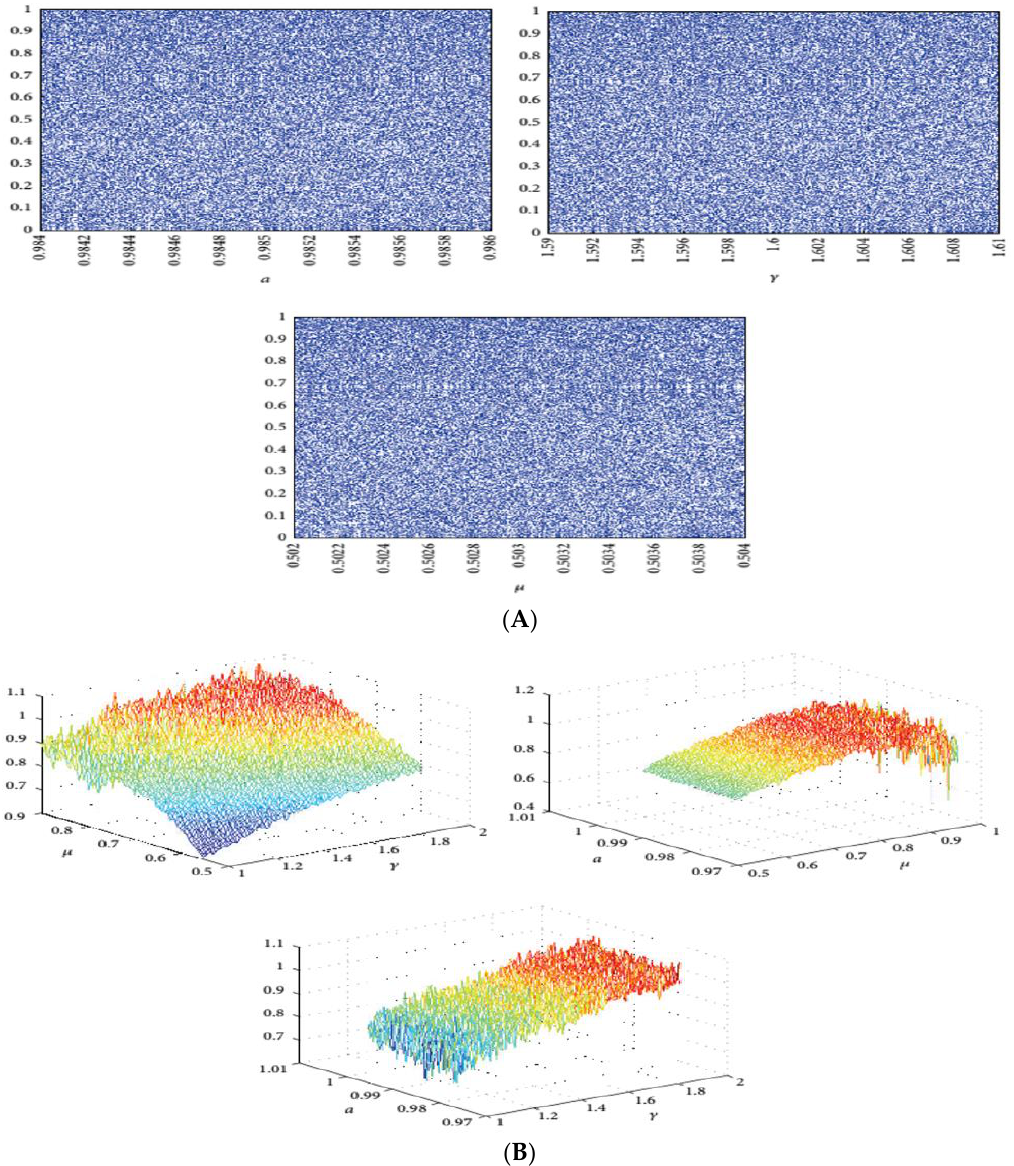
Figure 7. ( A ) Bifurcation plot versus parameter of hybrid chaotic map: ( B ) Lyapunov exponent versus parameter of hybrid chaotic map. Table 2. DNA complementary